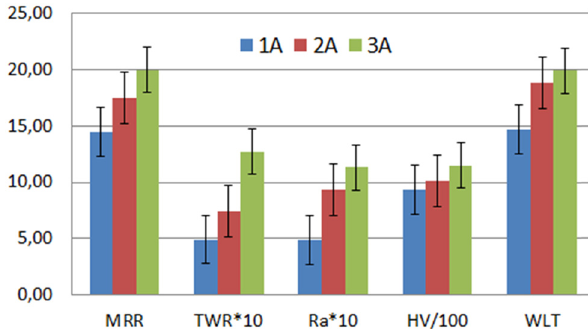
Figure 2: E ff ect of I on performance measures.